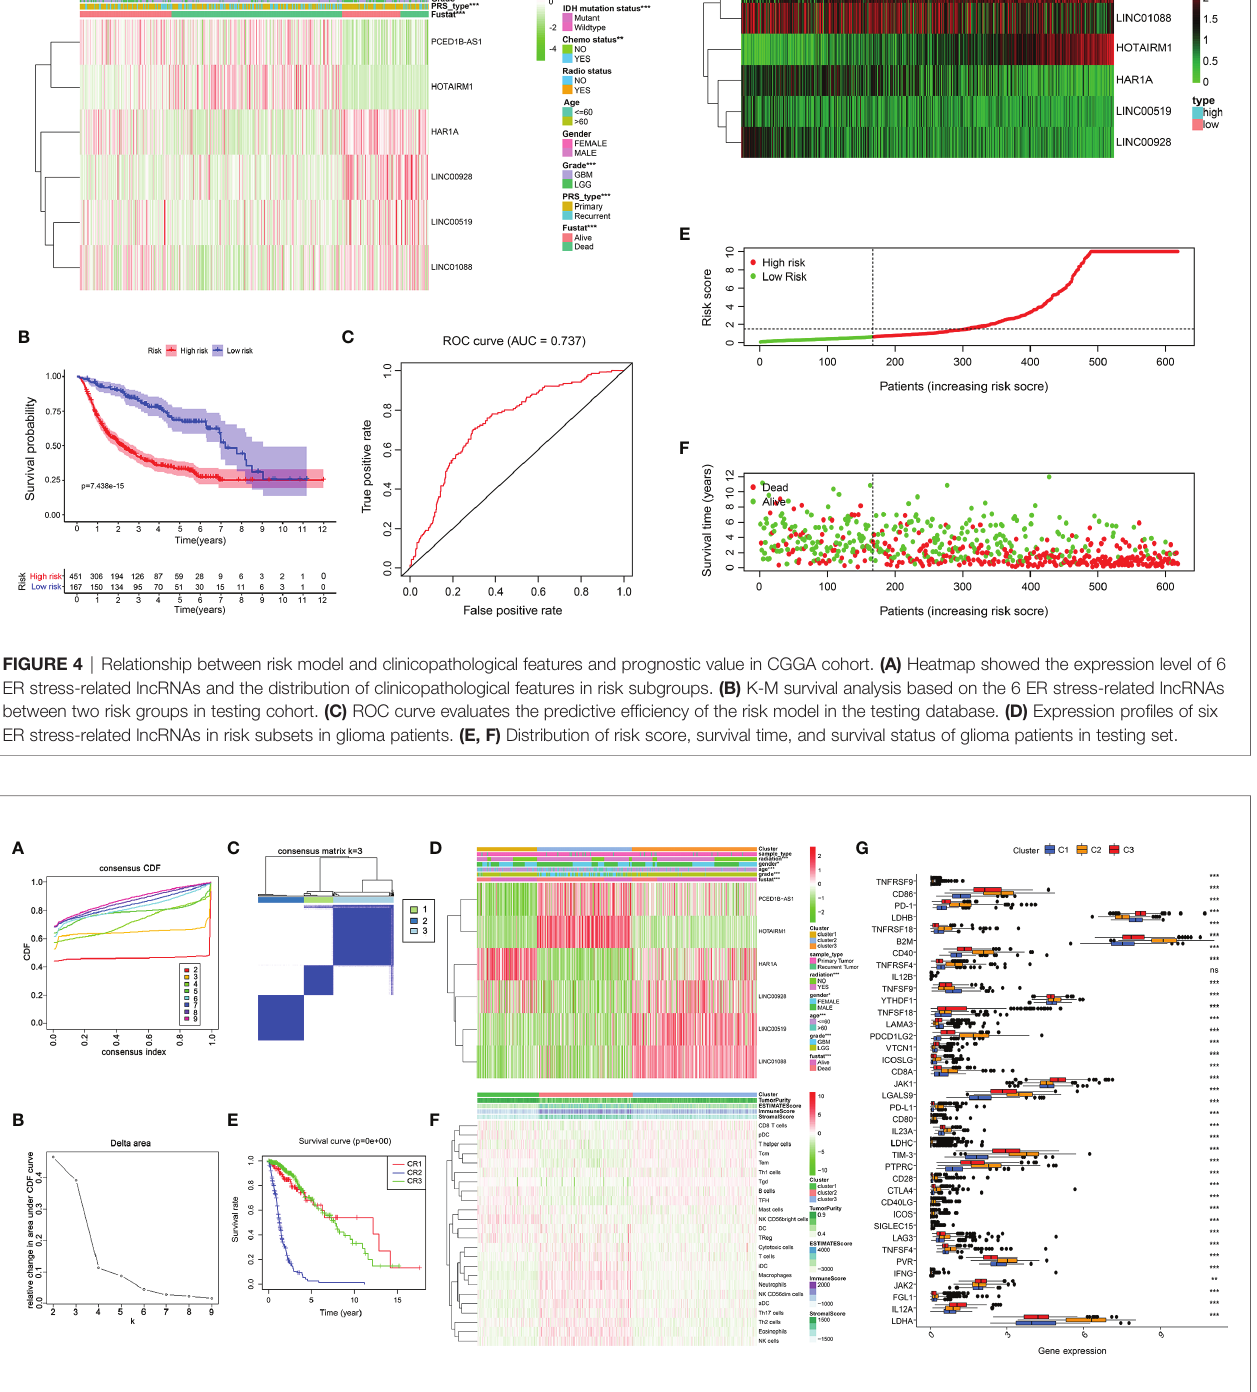
FIGURE 5 | Clinicopathological characteristics and immune microenvironment in consensus clustering subgroups of gliomas. (A) Consensus clustering CDF for k = 2 to 9. (B) Of the length and slope of the CDF curve as the index changes from 2 to 9. (C) The consensus score matrix of all samples when k= 3. ( D )Heatmap of ER stress-related lncRNAs between three clusters of the TCGA cohort. (E) K-M curves showed differences in OS among three subclusters in the training set. (F) The enrichment levels of 24 immune-related cells in three subgroups. (G) The boxplot shows the expression of 38 immune checkpoint molecules between the three subgroups. **p < 0.01, ***p <